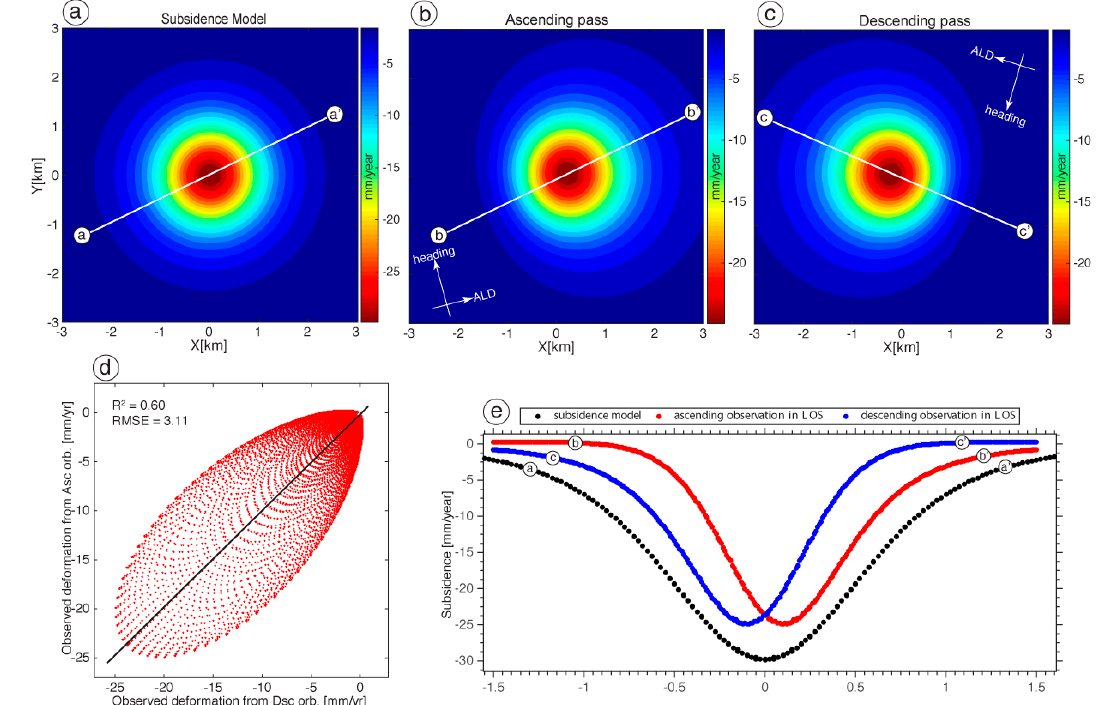
Figure 7. Effect of the looking geometry on the InSAR observations. ( a ) Simulated subsidence model induced by a single point source. ( b ) Expected LOS observations for ascending and ( c ) descending orbits. ( d ) Comparison of LOS displacements rates observed from ascending and descending orbits. ( e ) Cross section of the subsidence observations along the azimuth look directions (ALD).